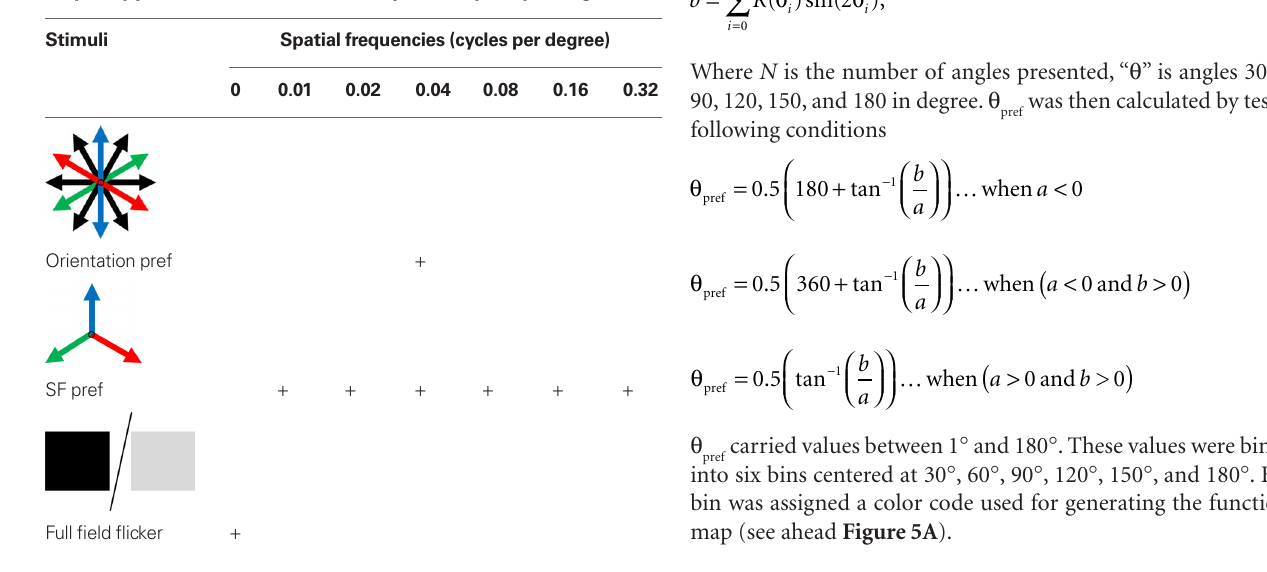
Table 1 | Stimuli set used for identifying orientation and spatial frequency preference in mice tested for spatial frequency